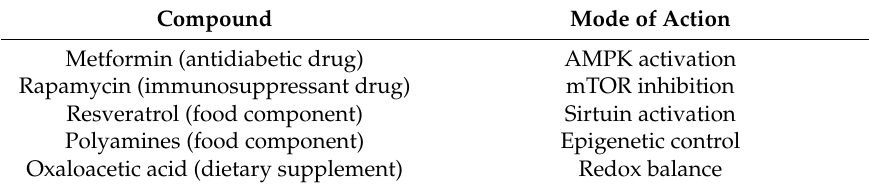
Table 1. Downstream-type calorie restriction (CR) mimetics (CRMs).